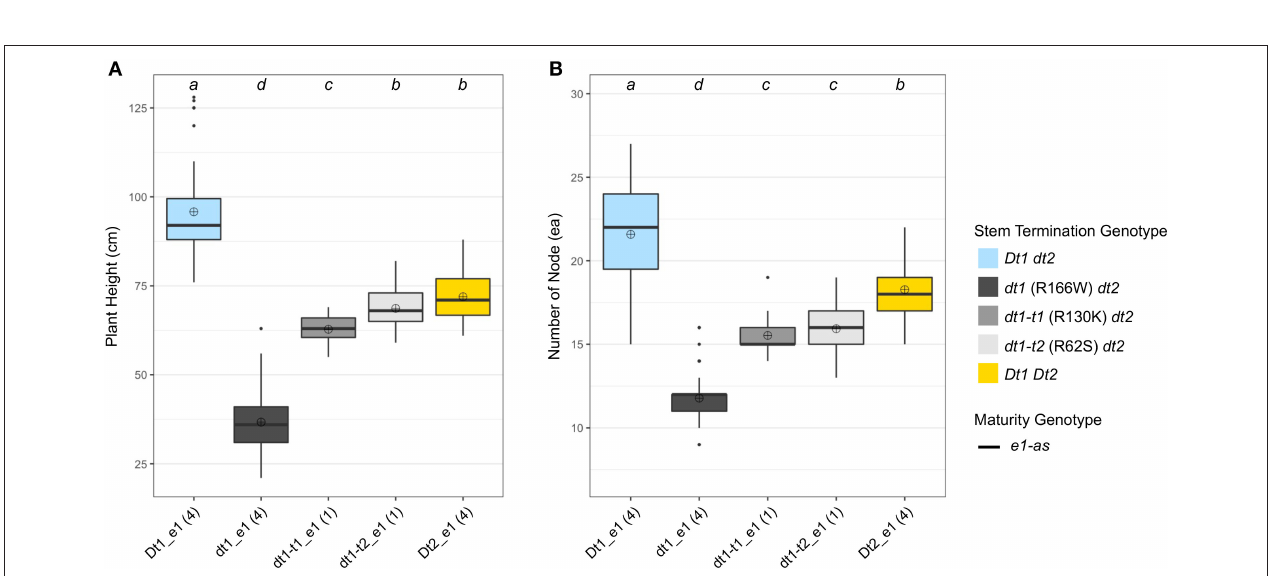
FIGURE 4 | Boxplots of plant height and number of nodes depending on genotype categories examined in 2020 in Columbia, MO (20MO). A total of 14 soybean lines with each allele combination for genes related to stem termination type and maturity were evaluated. The colors of each box were designated based on the allele status of the two genes, conferring stem termination type, Dt1 and Dt2 . All the experimental and control soybean lines had e1-as maturity alleles. Each genotype category has an unequal number of soybean lines and the number of lines was written in parentheses below each genotype category. The plant height and the number of nodes were measured from 15 individual plants per plot. ⊕ in each box represents mean values of each genotype category. The genotype categories marked with a common lower-case letter indicate that the means are not significantly different ( p = 0.05) according to Fisher’s Least Significant Difference (LSD) procedure. (A) Displays the distribution of final plant height at maturity in cm. (B) Shows the distribution of number of nodes counted from a main stem at maturity.